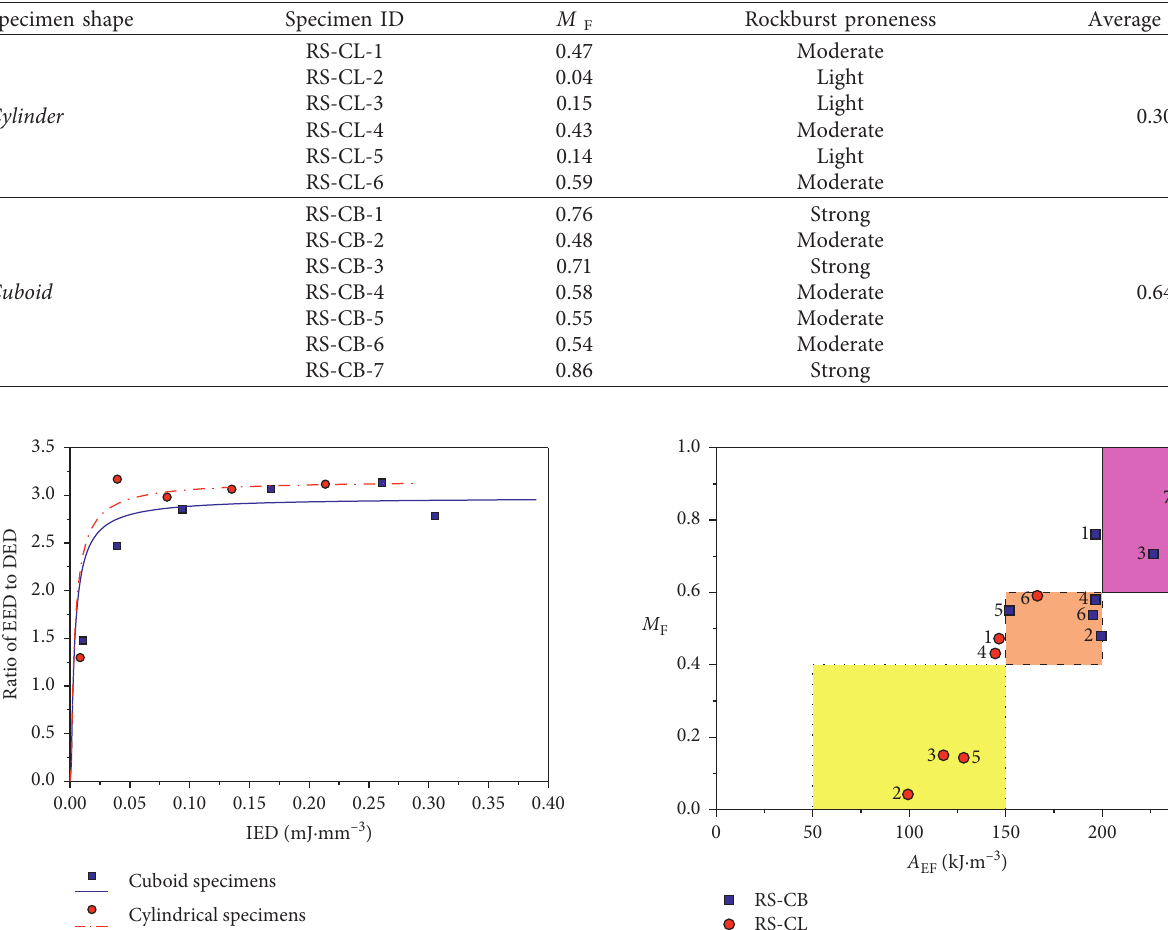
Figure 10: Relationship between IED and the ratio of EED to